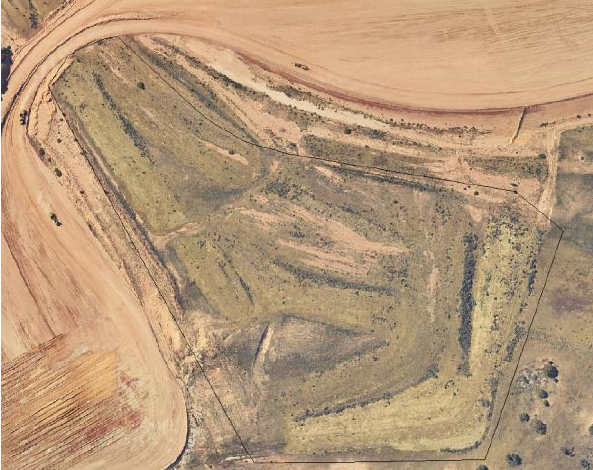
Figure 3: Aerial image of Site 2, a cluster of topsoil stockpiles at WRP Mine